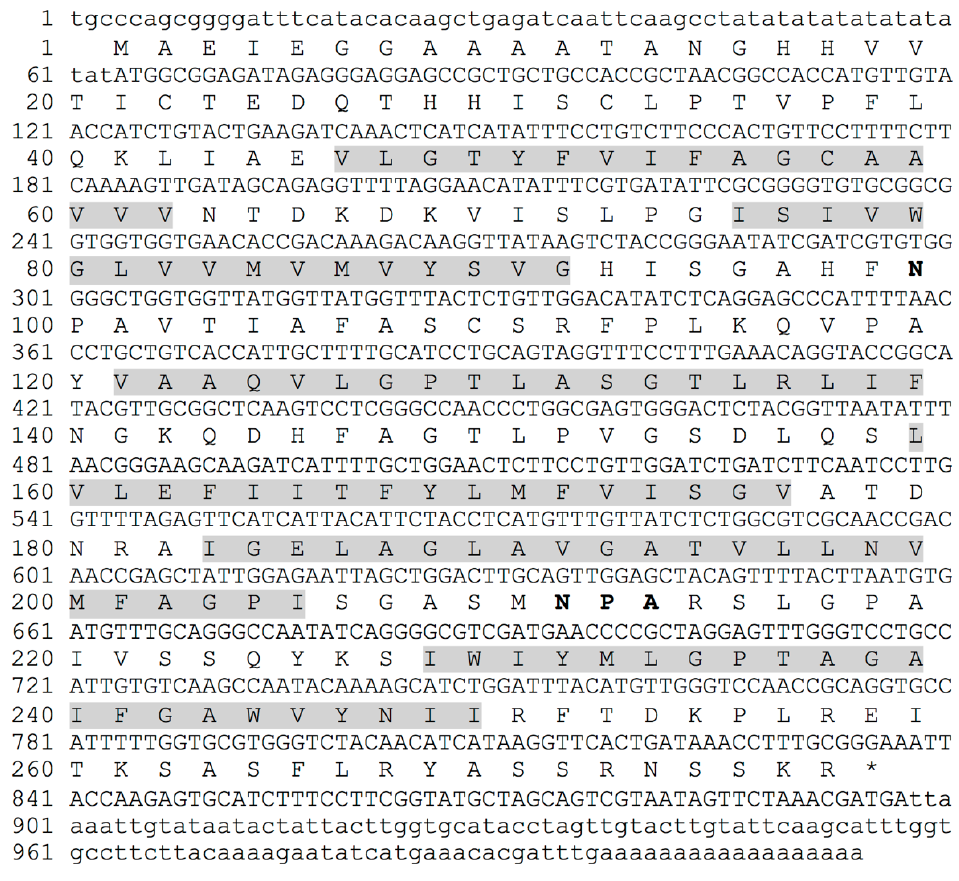
Figure 1. Nucleotide and deduced amino acid sequences of DvNip1 gene. NPA domain sequence is indicated with bold font for amino acids. Transmembrane TM1/TM6 are in grey background. Table 1. Primer nucleotide